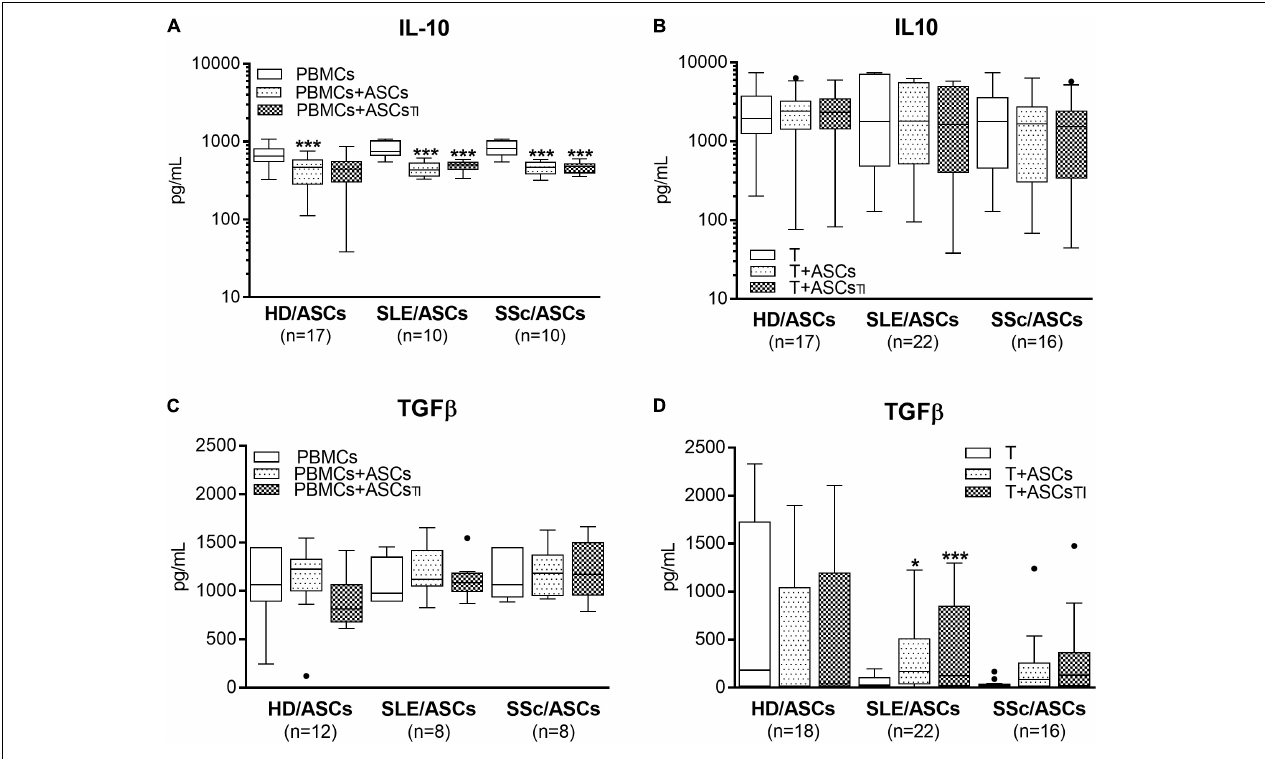
FIGURE 6 | Concentrations of anti-inflammatory cytokines in the co-cultures of ASCs with activated target cells. (A,C) PBMCs obtained from 12 healthy blood volunteers were stimulated with PHA and co-cultured in the same conditions as in Figure 1 with 5 HD/ASCs, 9 (A) or 5 (C) SLE/ASCs, and 9 (A) or 5 (C) SSc/ASCs. (B,D) CD4 + T cells were purified from 9 healthy blood volunteers, stimulated with anti-CD3/anti-CD28 antibodies and co-cultured in the same conditions as in Figure 2 with 5 HD/ASCs, 11 (B) or 10 (D) SLE/ASCs, and 8 (B) or 9 (D) SSc/ASCs. The concentrations of TGF β and IL-10 were measured in culture supernatants as described in the section “Materials and Methods.” Data are the results of the indicated number of experiments ( n ) and are shown as the Tukey’s boxes. * P < 0.05, ** P < 0.01, *** P < 0.001 for comparisons of cell co-cultures versus separate control cultures. There were no statistically significant differences between co-cultures containing HD/ASCs versus ASCs of SLE and SSc patients. Other explanations as in Figures 1 , 2